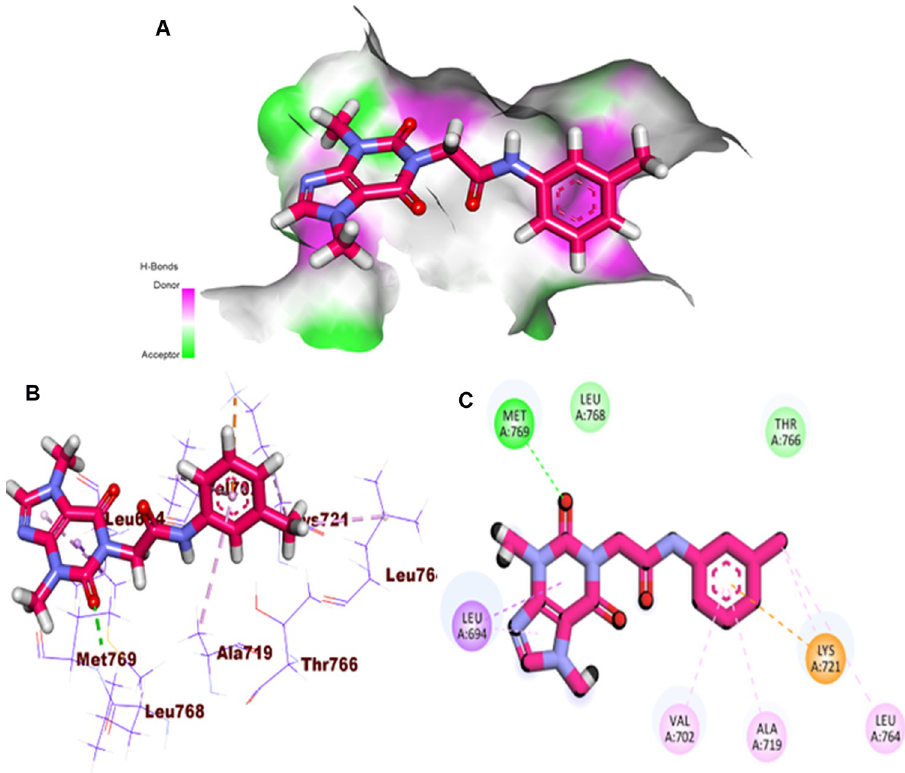
Fig 6. A: Mapping Surface (MS), B: 3D, and C: 2D close view of T-1-MTA inside the EGFR WT .